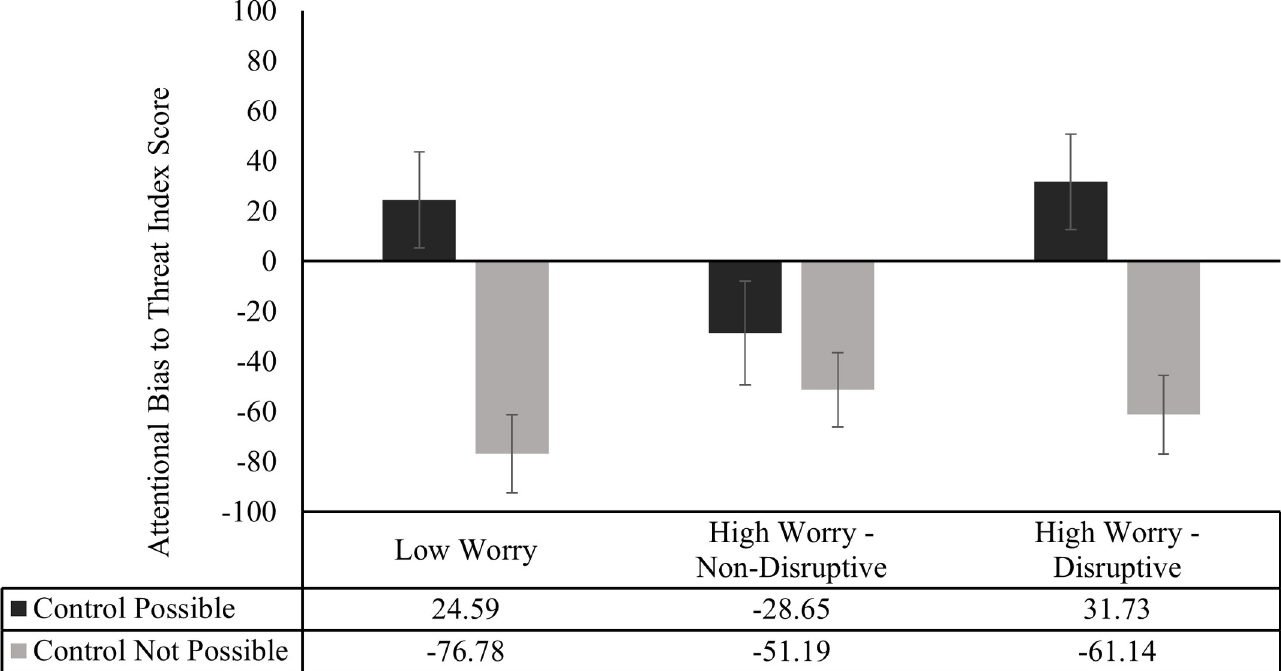
Fig 3. Attentional Bias to Threat Index scores for each group in control possible and control not possible blocks. Errors bars are standard error bars.